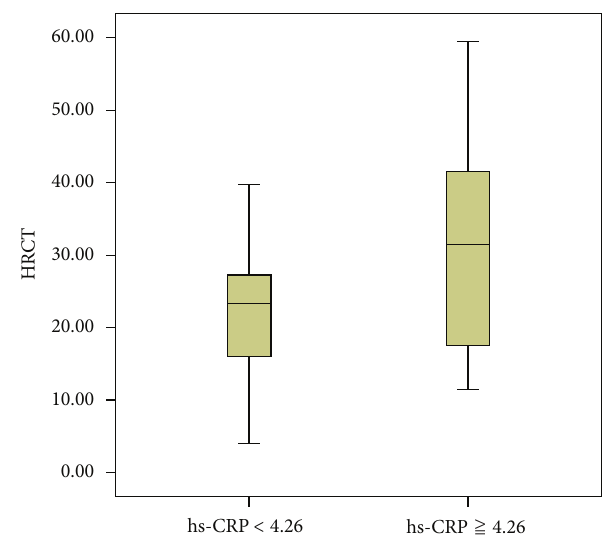
Figure 3: HRCT scores in higher and lower serum hs-CRP groups. HRCT scores were significantly higher in bronchiectasis patients with higher hs-CRP (mg/L). Boxes, median and interquartile range; whiskers, full range of values obtained; 𝑃 = 0.004 .